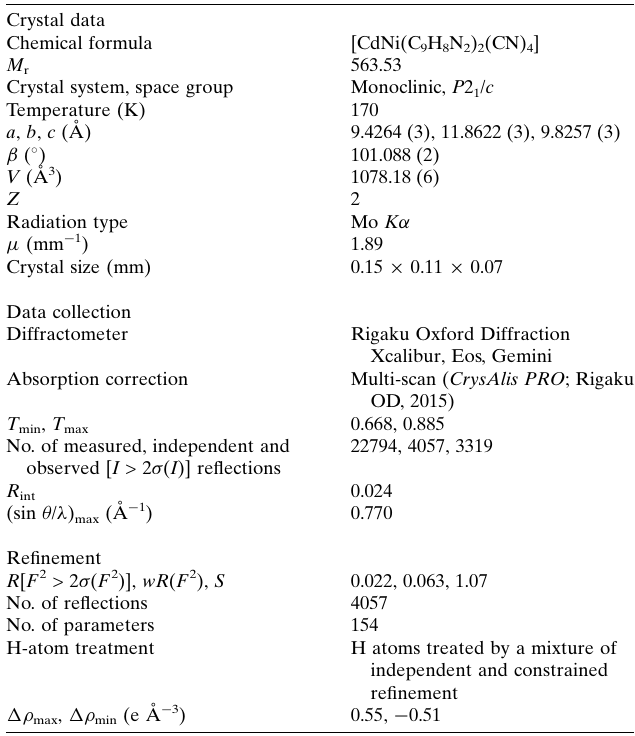
Table 2 Experimental details. Crystal data Chemical formula